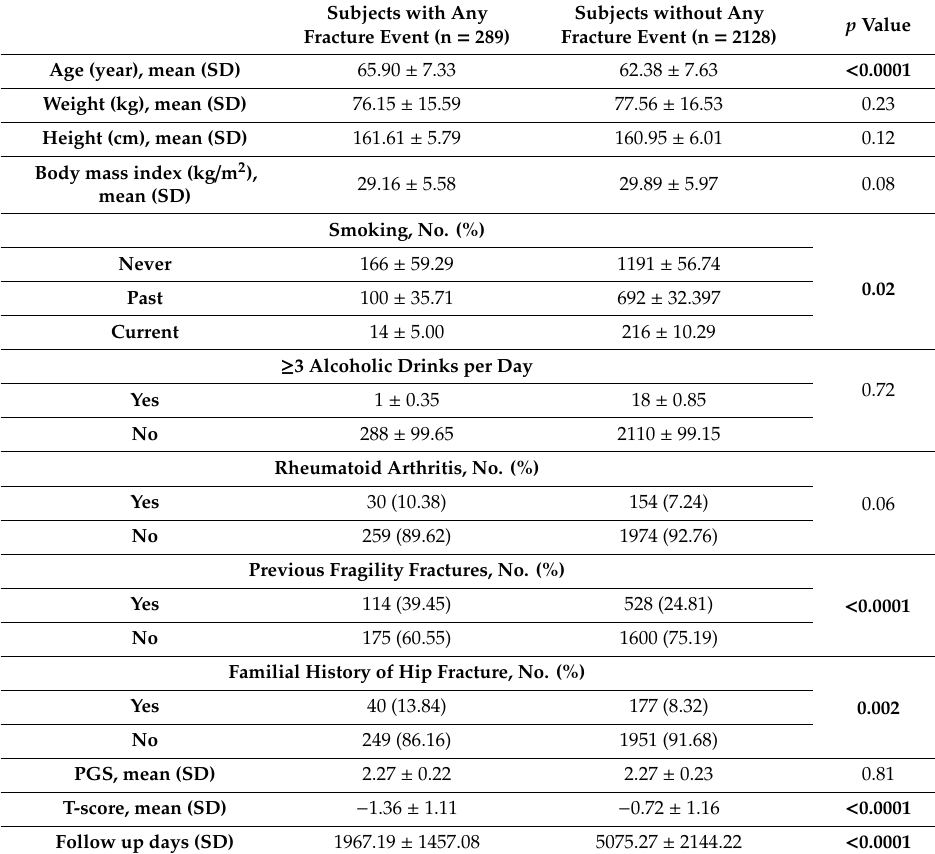
Table 1. Baseline characteristics of 2417 women with and without any subsequent fracture during 19 years of follow-up. Subjects with Any Fracture Event (n =